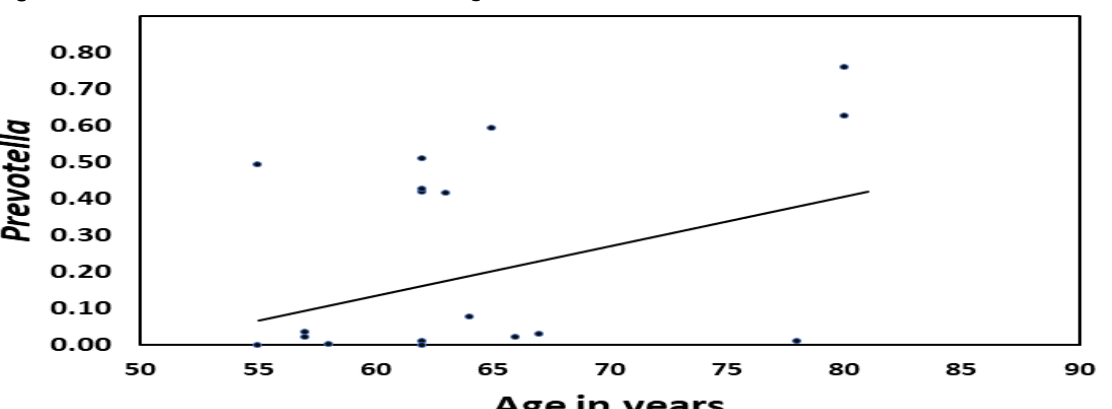
Figure 3. Correlation between Prevotella and